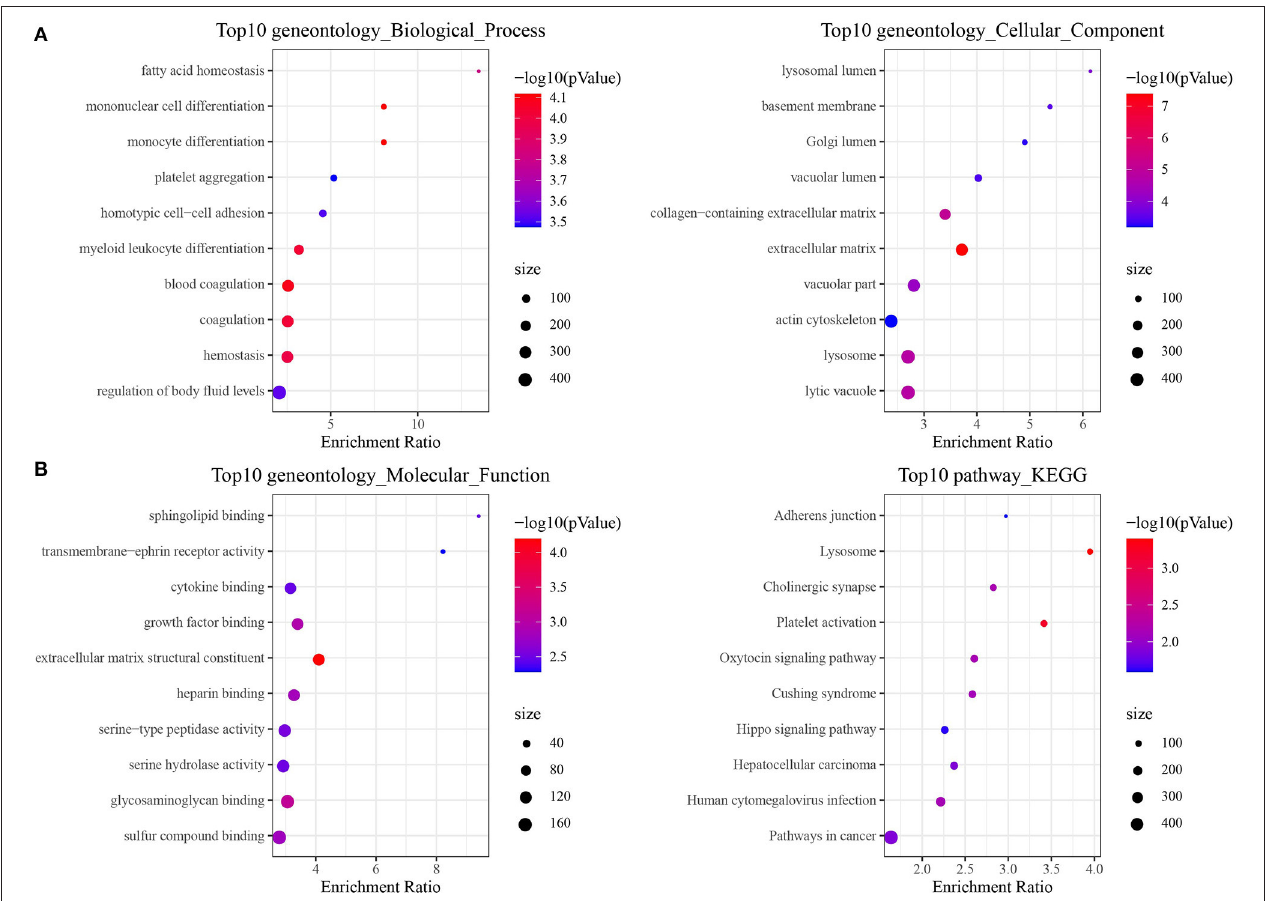
FIGURE 6 | Enrichment pathway analysis of epi-lncRNAs in osteosarcoma prognostic signature. (A) GO analysis of 486 epi-lncRNAs-related PCGs, including biological process (BP), cellular component (CC) and molecular function (MF). (B) KEGG analysis of 486 epi-lncRNAs-related PCGs showed the highest 10 pathways of enrichment